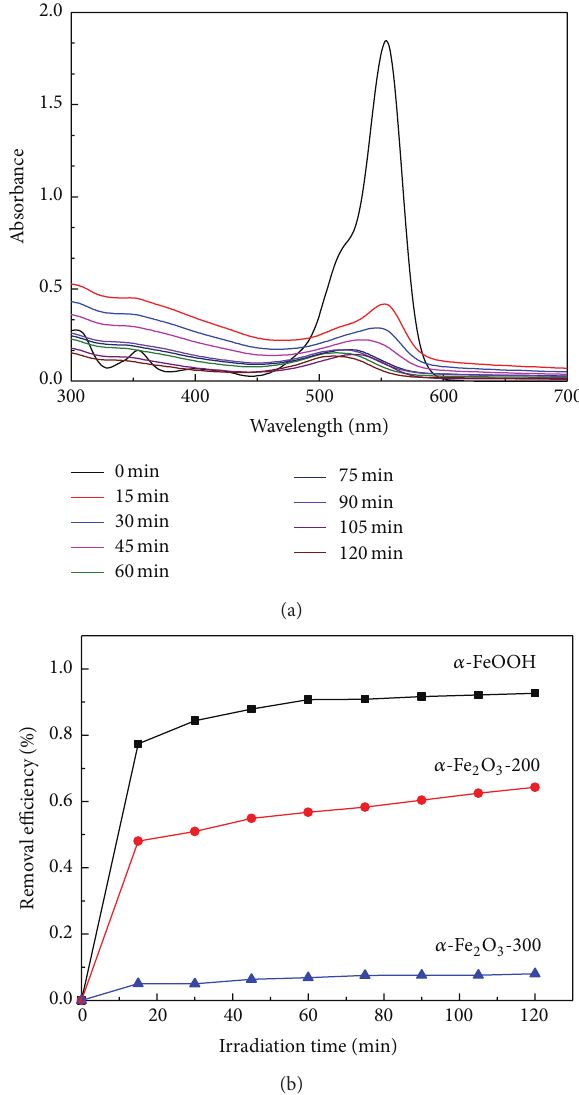
Figure 5: (a) Temporal evolution of RB absorption spectra with an initial concentration 𝐶 0 of 2 × 10 −5 mol ⋅ L −1 under UV light with porous 𝛼 -FeOOH nanoparticles as photocatalyst; (b) removal efficiency of RB after photodecomposition by the different catalysts under UV